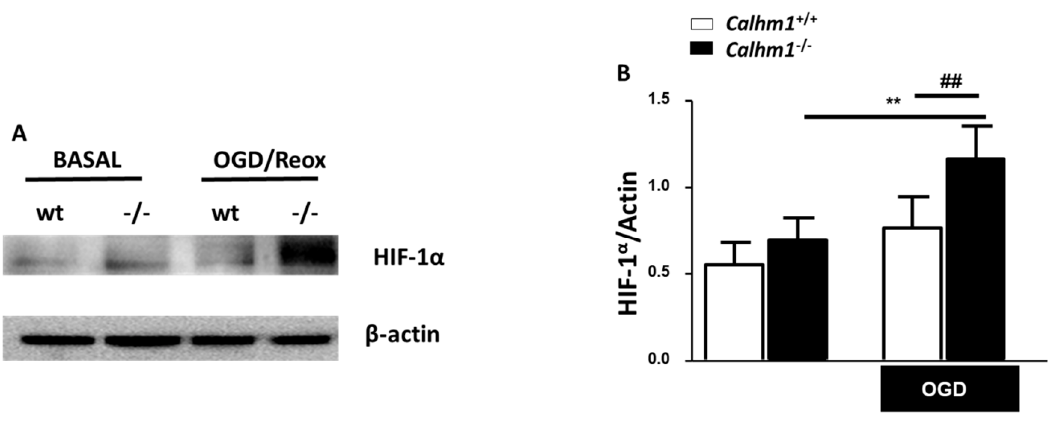
Figure 5. HIF-1 α protein is upregulated in Calhm1 − / − hippocampal slices after exposure to OGD/Reox. ( A ) Representative image of the bands showing the expression of HIF-1 α by western-blotting obtained from Calhm1 +/+ and Calhm1 − / − hippocampal slices subjected to OGD/Reox. ( B ) Quantitative expression of HIF-1 α is represented in bars using β -actin for normalization. Data are the mean ± S.E.M of eight different animals from each group. ** p < 0.01 versus basal Calhm1 − / − ; ## p < 0.01 compared to OGD Calhm1 +/+ . Paired t-test was performed.